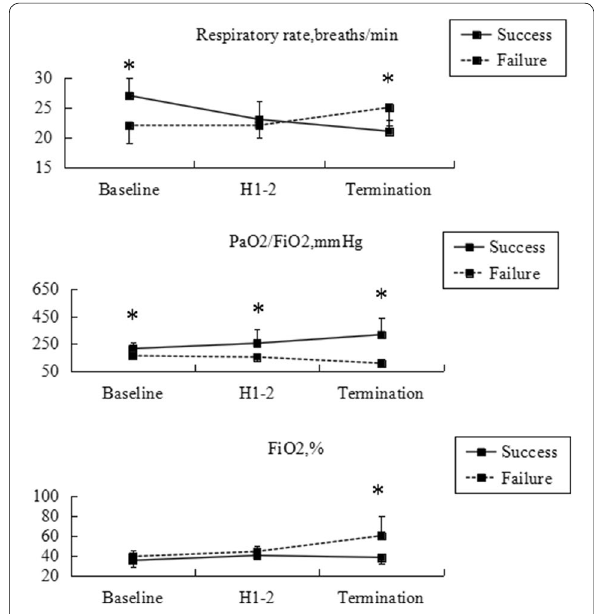
Fig. 3 Respiratory rate, PaO 2 /FiO 2 and FiO 2 at baseline, 1–2 h and termination of HFNC. * p < 0.05 for comparisons between two groups